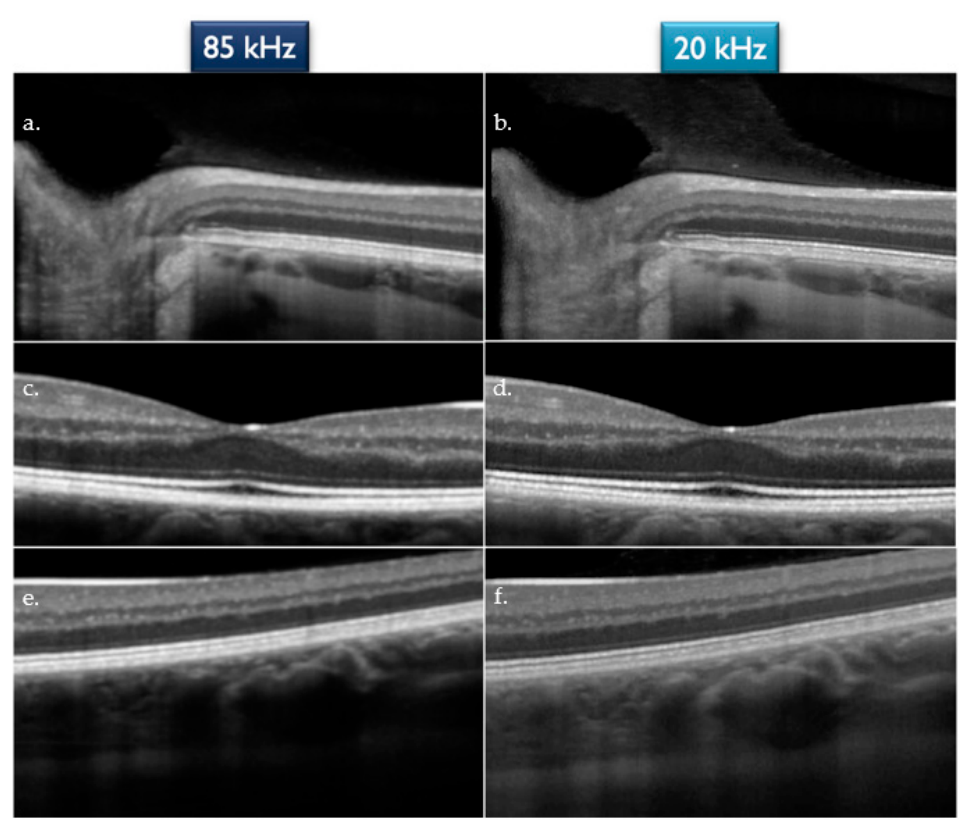
Figure 2. ( a , b ) Visualization of the vitreo-retinal interface for the 85 kHz and 20 kHz OCT, respectively. ( c , d ) Characterization of the retinal layers for the 85 kHz and 20 kHz OCT, respectively; ( e , f ) Visualization of the sclero-choroidal interface for the 85 kHz and 20 kHz OCT, respectively.